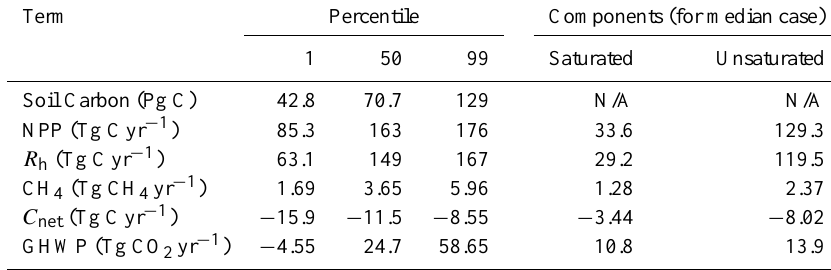
Table 5. Annual average carbon budget terms over the period 2001–2010.